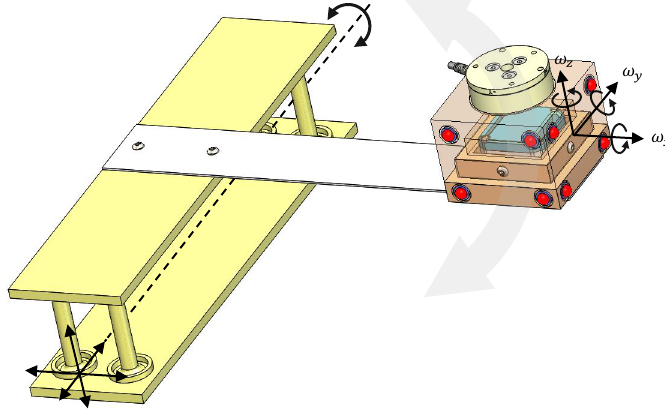
Figure 6. Experimental conditions: Translation and